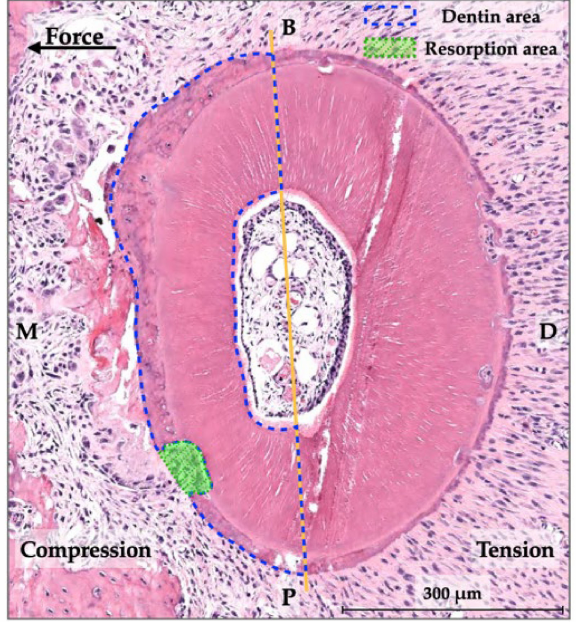
Figure 5. Histomorphometric analysis of root resorption. M = mesial; D = distal; B = buccal; P = palatal (magnification, 40 ×